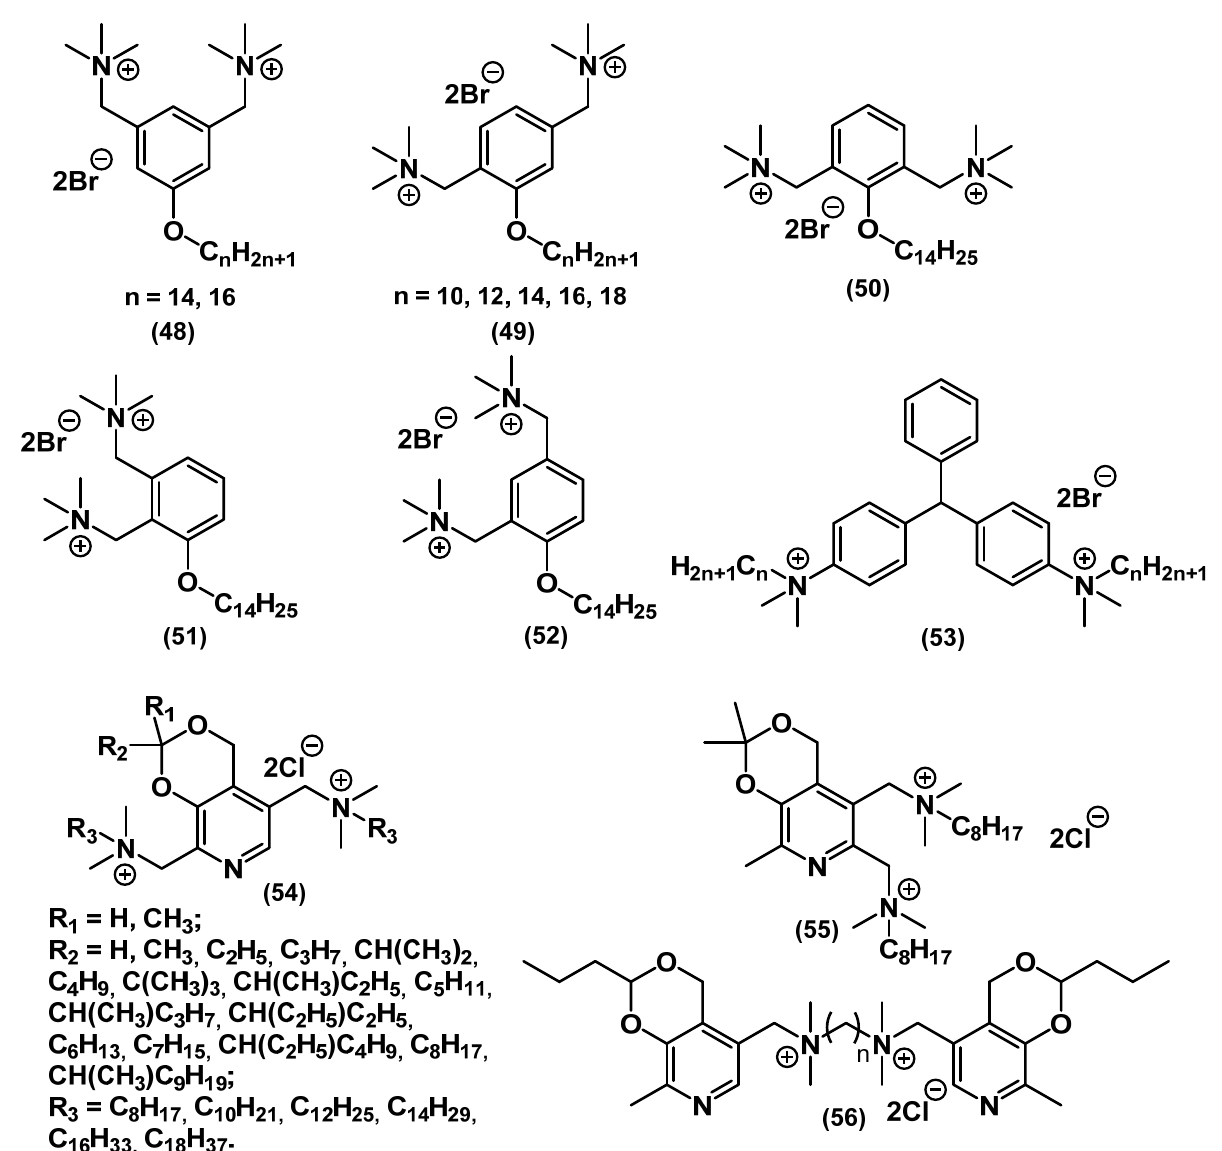
Figure 21. Alkyl bis-QACs containing aromatic spacers.